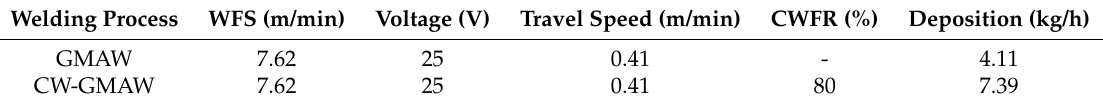
Table 2. Welding parameters.